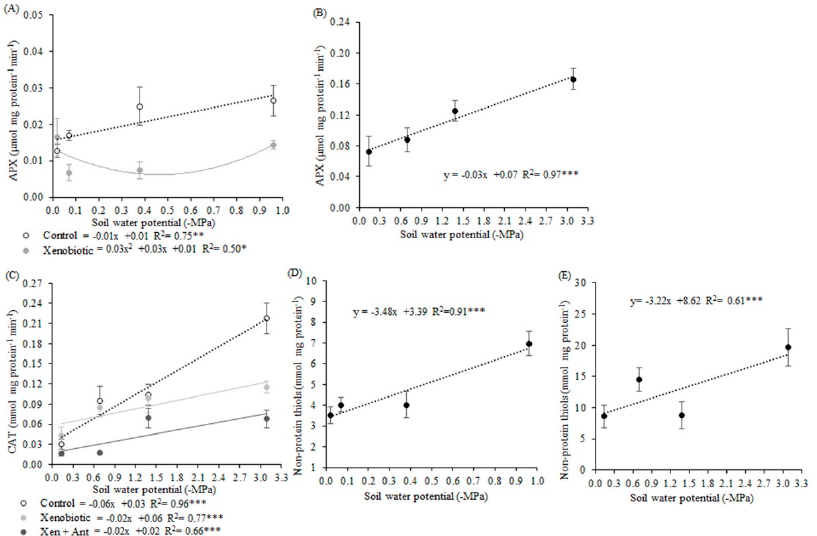
Figure 6. Ascorbate peroxidase activity in the first experiment ( A ) and the second experiment ( B ). Catalase activity in the second experiment ( C ). Non-protein thiols in the first experiment ( D ) and the second experiment ( E ) in soybean plants under different soil water potentials and xenobiotic and antioxidant agent applications. Note: asterisks indicate error probability as * = 10%, ** = 5%, and *** = 1%, respectively. Vertical bars represent the standard error of the samples.